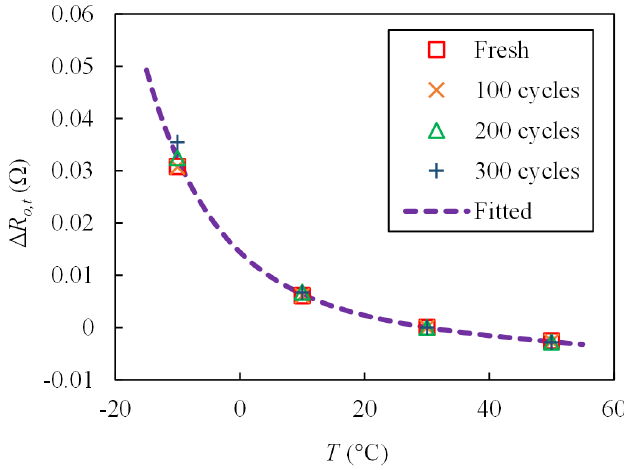
Figure 7. The relationship of Δ R o ,t with